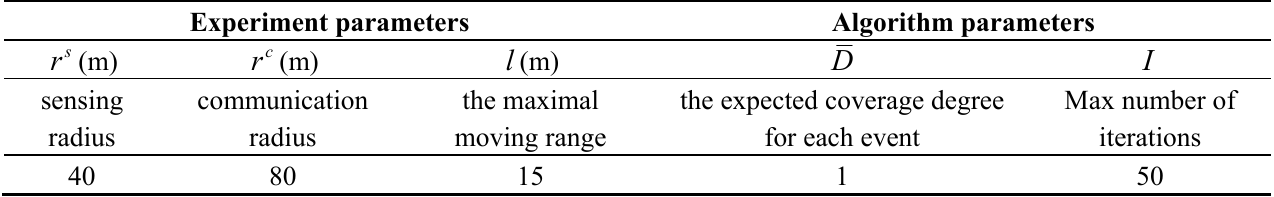
Table 1. Parameter settings.